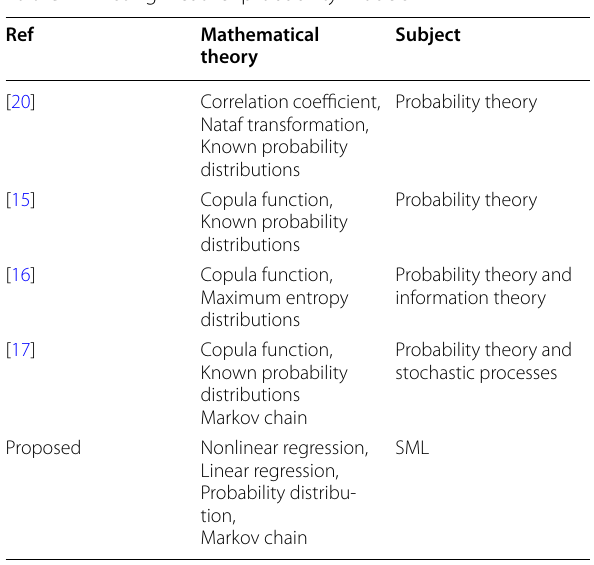
Table 2 Existing weather probability models